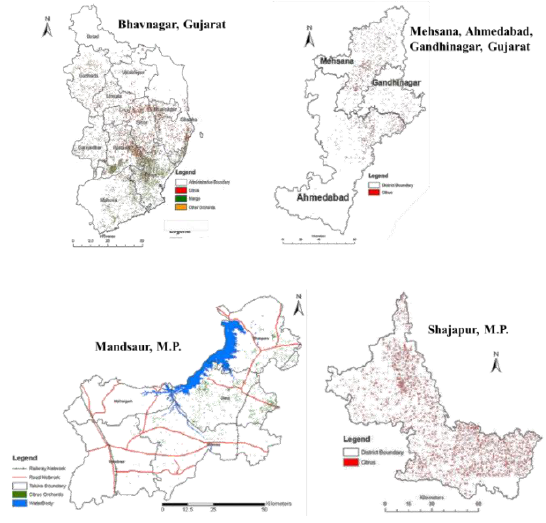
Figure 9. Classified Citrus orchards for districts of Gujarat and